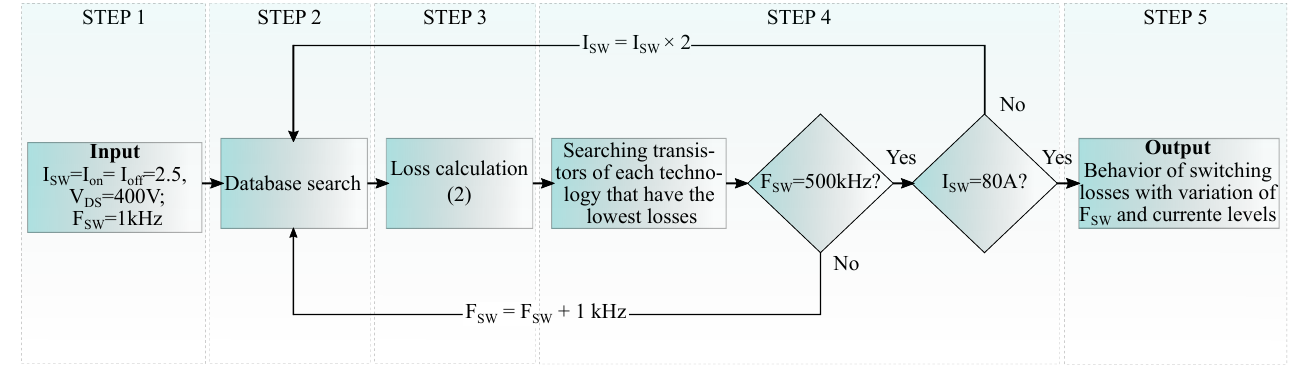
Figure 6. Flowchart: methodology for the selection of the MOSFET with lowest switching losses for each